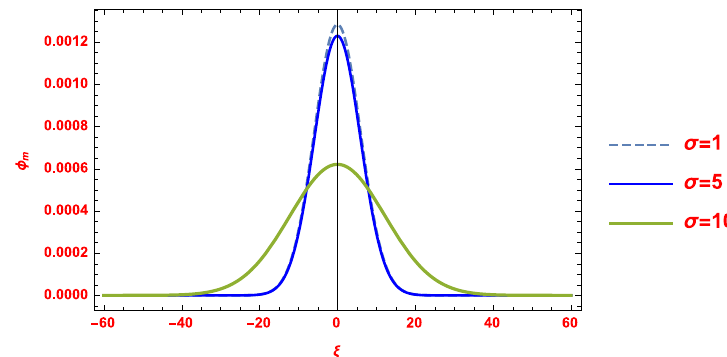
Figure 8. φ m varying along ξ for different (cid:101) .